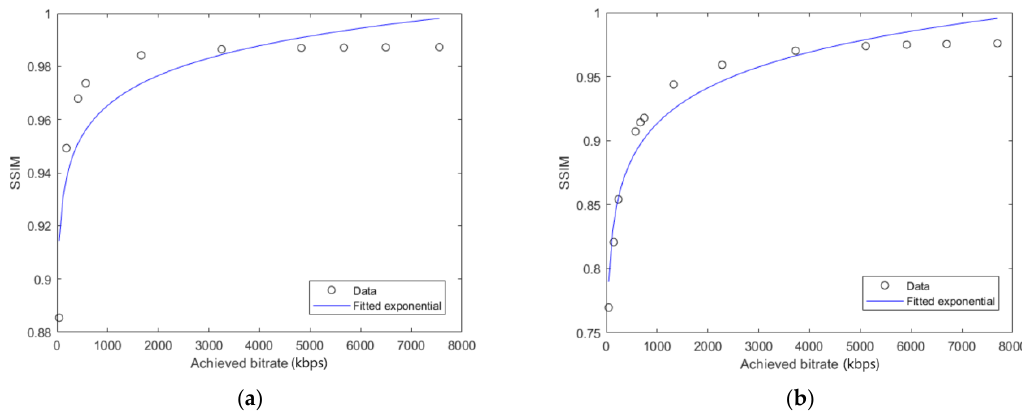
Figure 3. Fitted curves of data points presenting the envelope of SSIM-achieved bitrate curves for video sequences: ( a ) Chimera 1102347 (C47); ( b ) Pedestrian Area (PA).